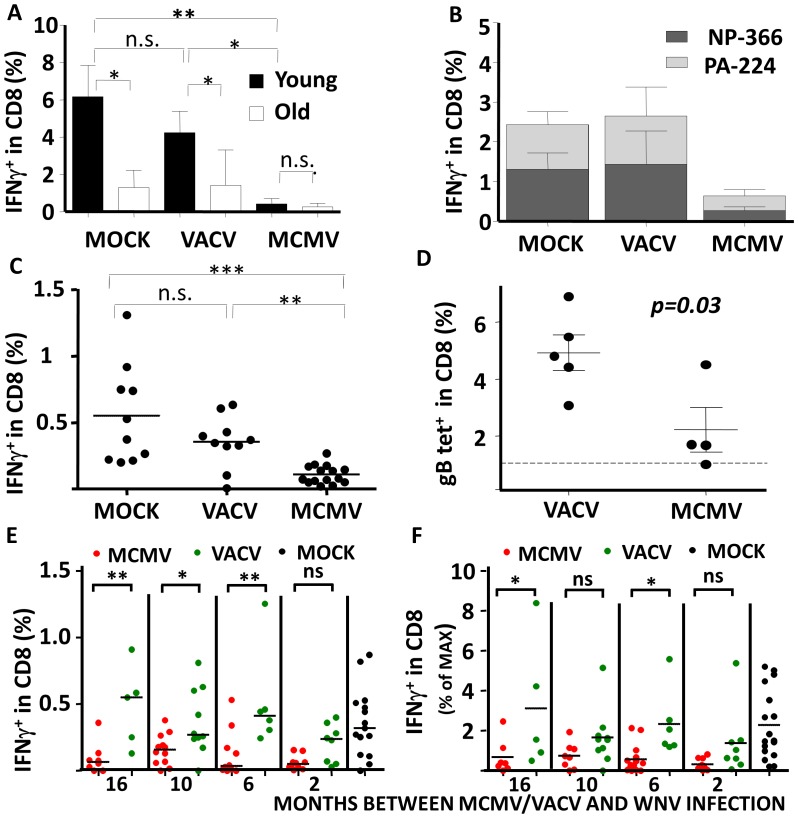
CD8 T-cell responses to superinfection upon MCMV infection.(A) groups of 3 (young) and 12 (old) month old mice were primed with 105 PFU of MCMV, 106 PFU of VACV-WR or PBS (MOCK), and challenged 5 months later with 300 EID of influenza virus, PR/8 strain, intranasally (i.n.). 7 days post challenge blood lymphocytes were tested by ICCS for IFNγ responses to a 9 h in vitro stimulation with the NP366 peptide in the presence of BrefeldinA. Mean IFNγ responses in animal groups (n = 5/group)+SD is shown on the y axis. (B) 12 month-old mice were primed as indicated and challenged 5 months later with Influenza. The frequency of peptide specific cells in the blood CD8 pool was defined by peptide restimulation and ICCS. Group average (+SD) values for either peptide are indicated on the y axis. (C) Mice were primed with 105 PFU of MCMV or 106 PFU of VACV-IE1 at 2 months of age, and i.p. challenged with 50 PFU of West Nile Virus at 8 months of age. 7 days later, blood lymphocytes were in vitro stimulated with a pool of two immunodominant H2d restricted WNV peptides and analyzed by ICCS. The frequency of IFNγ expressing T-cells in the CD8 pool of individual mice is displayed on the y axis. Horizontal lines indicate medians. (D) C57BL6/DBA2 F1 mice were primed with MCMV or VACV-IE1 at 3 months of age, challenged with HSV-1 at 8 months of age and frequencies of HSV-1 specific responses were determined 7 months later by pMHC tetramer staining and FCM. Each mouse is indicated with a symbol, horizontal lines are means, the dashed line shows the detection threshold. The p value for Mann-Whitney analysis is shown. (E, F) Mice were primed with MCMV or VACV-IE1 at 6, 12, 16 or 20 months of age, and assayed for responses to WNV challenge at 22 months of age (16, 10, 6 or 2 months post prime, as indicated below axis) using the protocol as in panel C. Each mouse is indicated with a symbol, horizontal lines are means. (E) % of CD8 cells responding to peptide stimulation in ICCS. (F) Leukocytes were in parallel assayed by polyclonal stimulation with anti-CD3 antibodies, and the peptide specific response was normalized to the CD3 (Max) response. Values in panels A, C, E and F were compared by 1-way ANOVA followed by Bonferroni comparison of individual columns, and significance is indicated (n.s. - p>0.05, *- p<0.05, ** - p<0.01, *** - p<0.001).